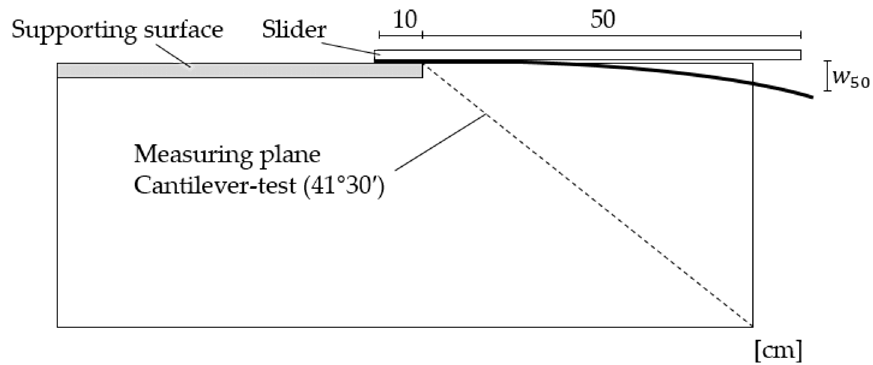
Figure 2. Schematic representation of the adapted Cantilever test used in this work.